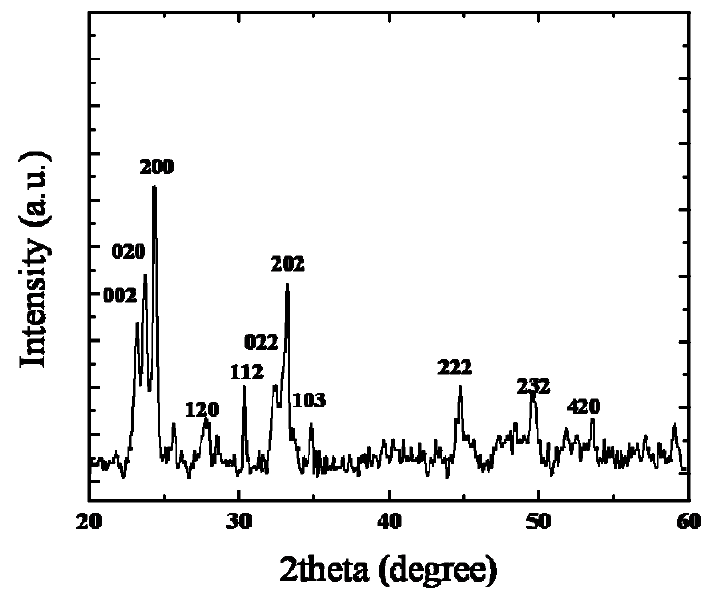
sintered at 500 °C.